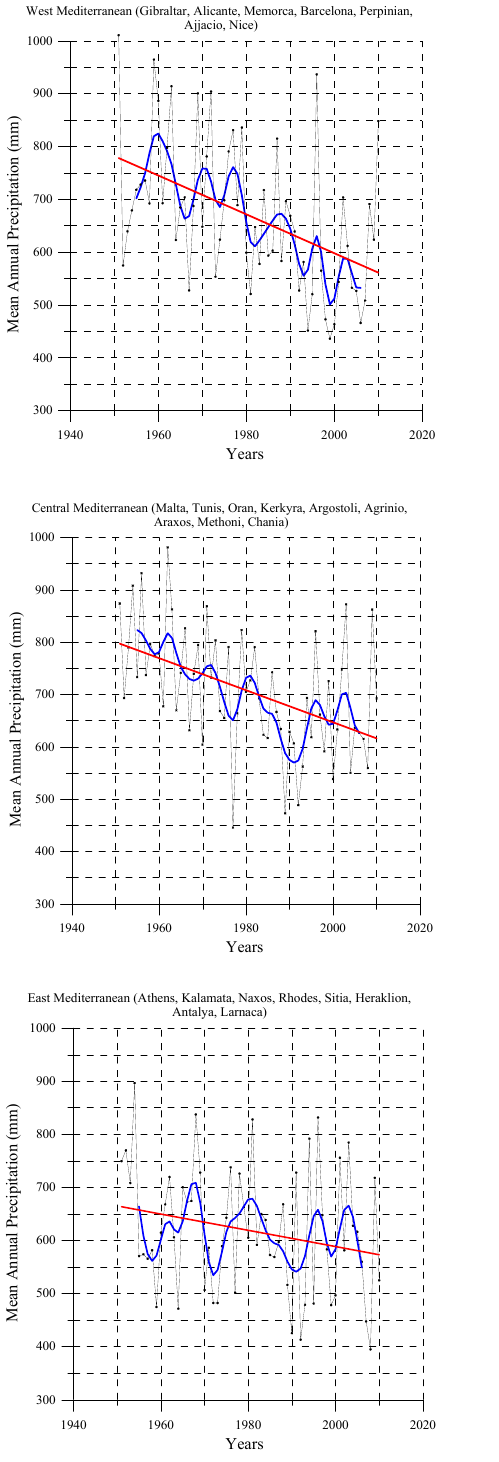
Figure 5 . Composite annual precipitation (left graphs, period 1951-2010) and annual number 1 Fig. 5. Composite annual precipitation (left graphs) and annual number of rain days (right graphs) from representative stations of the west of rain days (right graphs, period 1965-2010) from representative stations of the west (upper), 2 (upper), central (middle) and east (lower) Mediterranean region, along with 9-yr Gaussian filter (blue line) and linear trend (red central (middle) and east (lower) Mediterranean region, along with 9-year Gaussian filter 3 (blue line) and linear trend (red line). 4